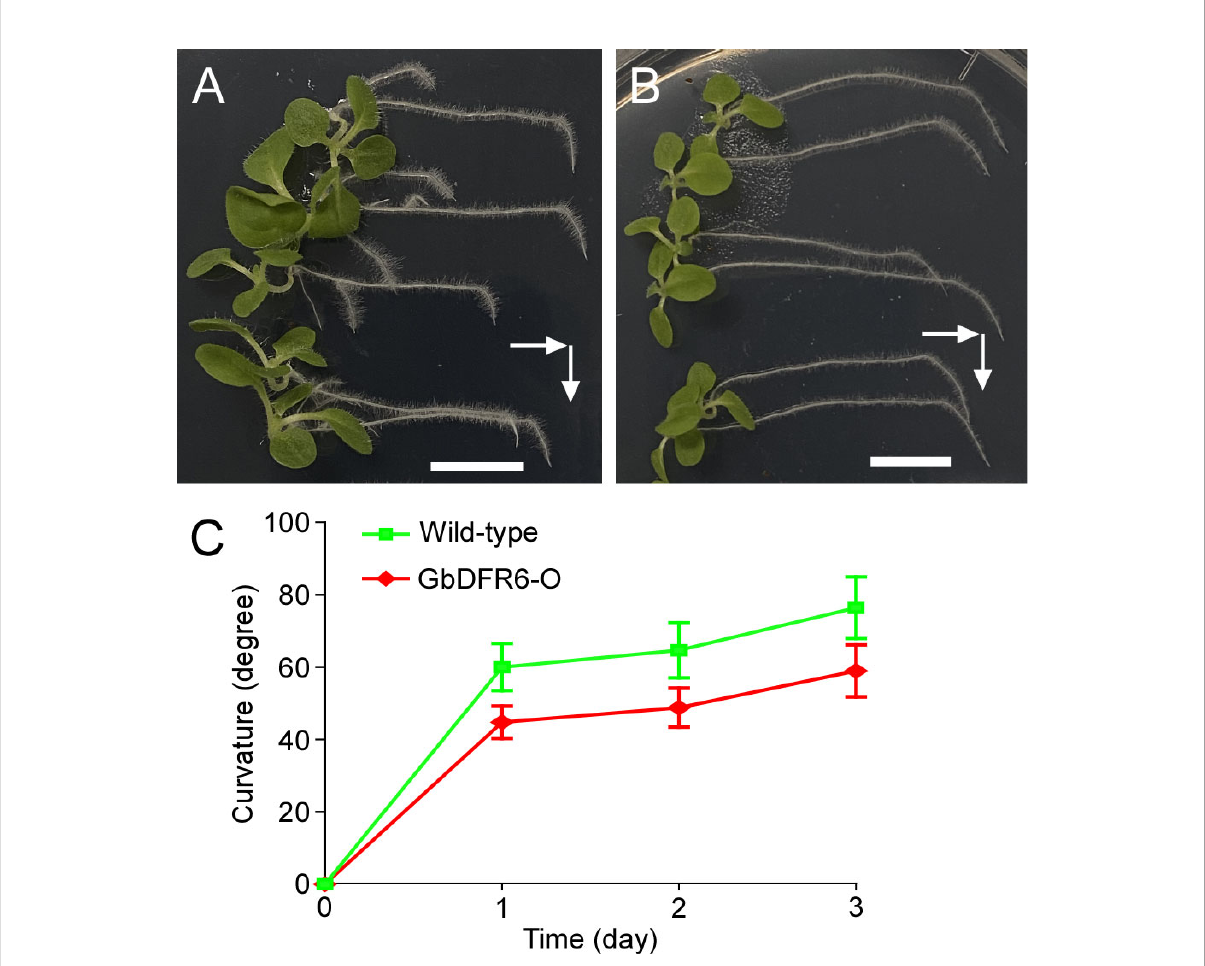
FIGURE 2 Gravitropic responses of wild-type and transgenic tobacco roots. One-month-old wild-type (A) and transgenic (B) tobacco seedlings were laid down from an upright to horizontal position. White arrows indicate gravitational directions. Bars = 1 cm. (C) The curvature of the primary roots at different time points. The green line represents wild-type tobacco plants, whereas the red line represents transgenic tobacco plants. Means and SDs are shown (n =